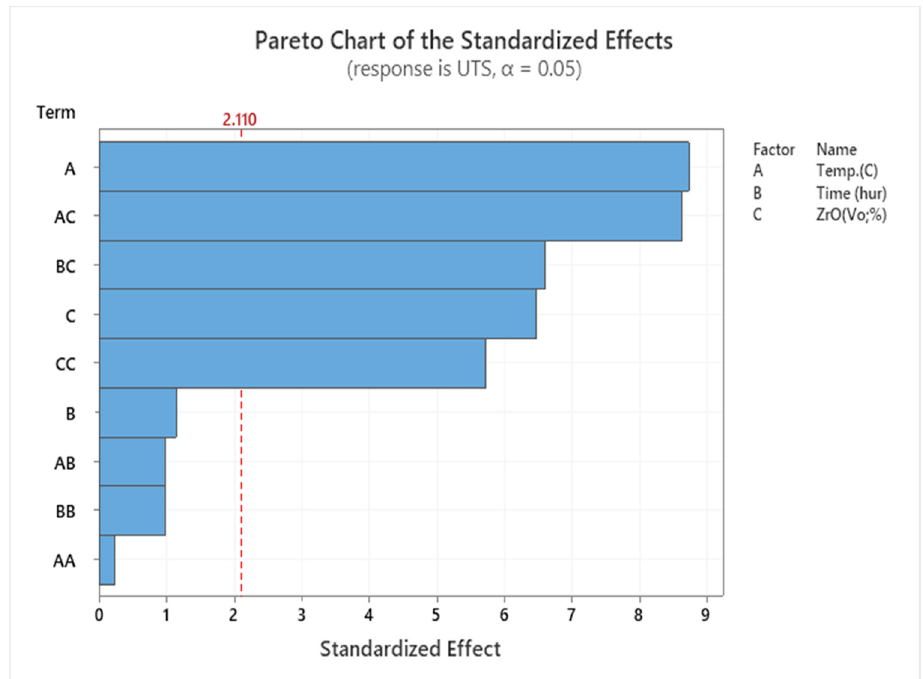
Figure 6. Pareto chart for UTS. Table 6. The analysis of variance of UTS by RSM.